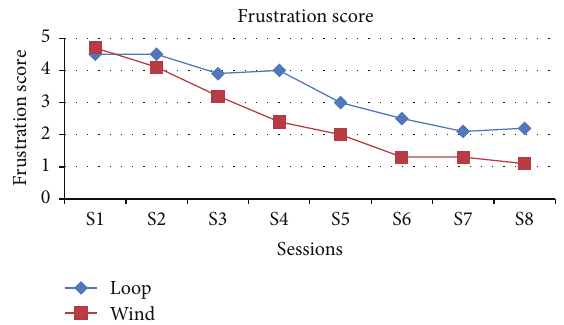
Figure 7: Graphical representation of both groups in view of dexterity of complete procedure in the end of each